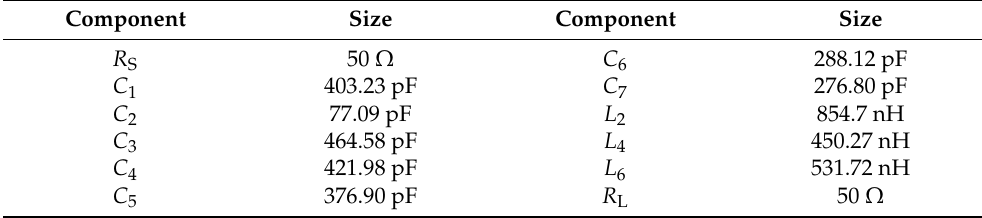
Table 1. Component parameters for the RLC ladder prototype.